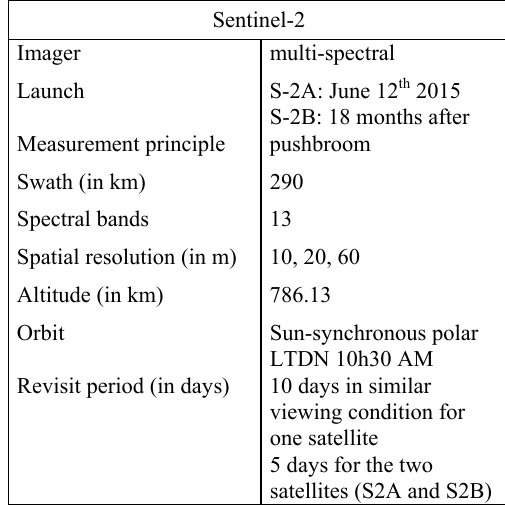
Table 1. Summary of mission specifications. LTDN refers to Local Time of Descending